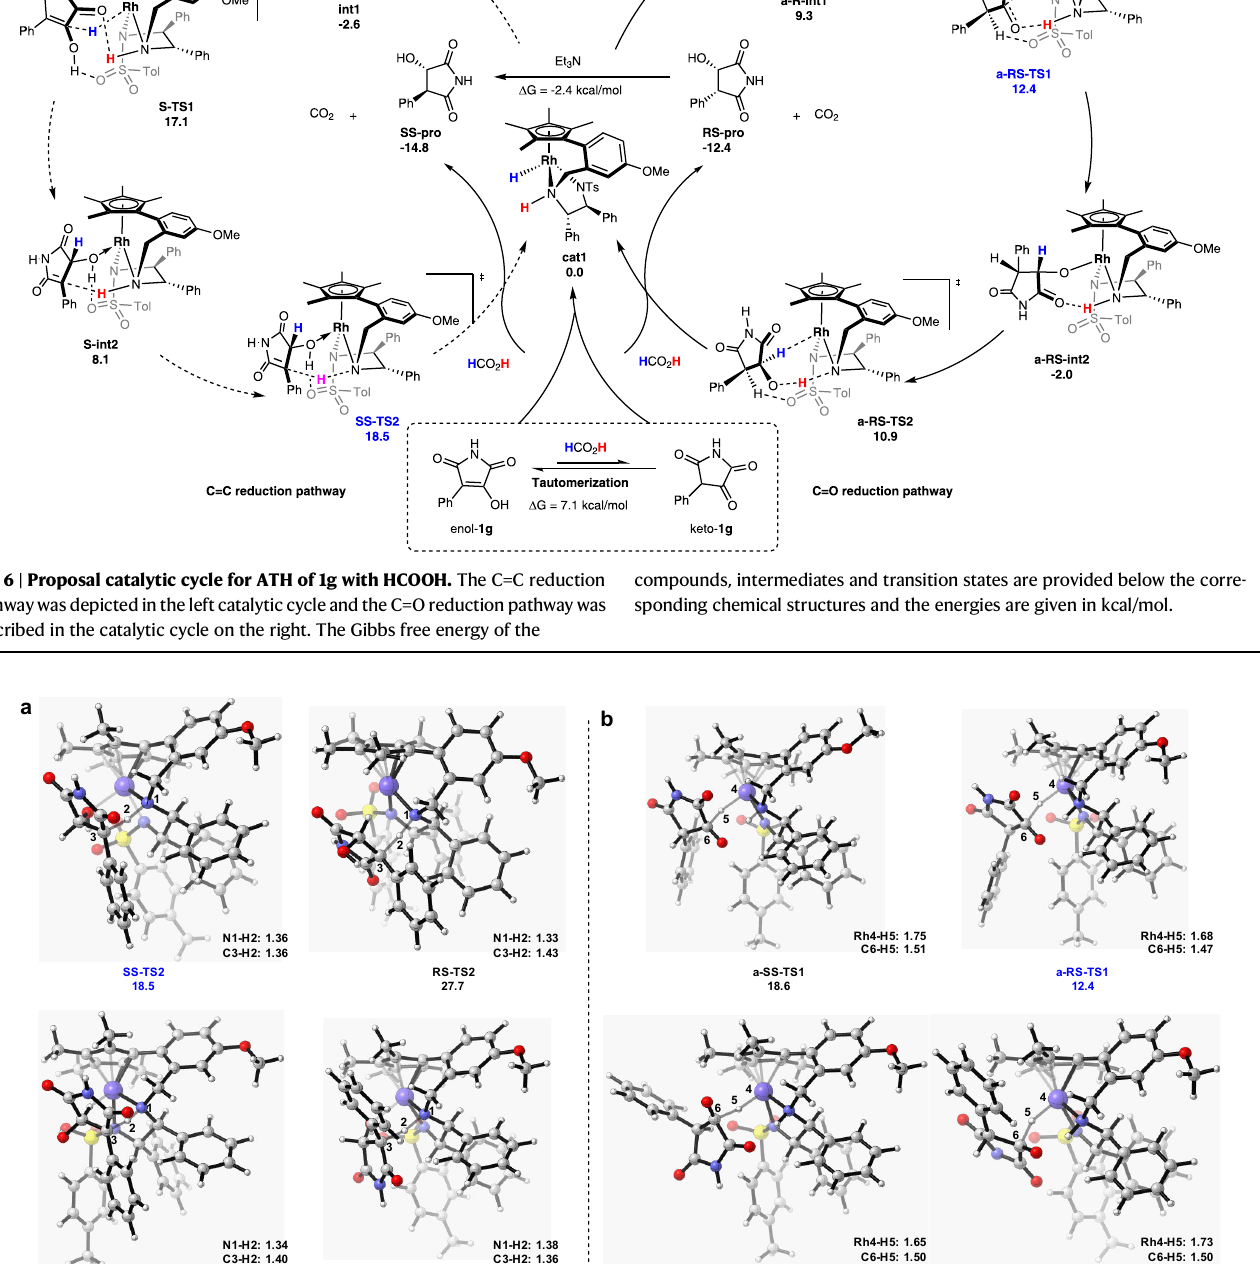
Fig. 7 | The free energies of the transition states of the enantio-determining steps. a Calculated transition states for the C=O bond reduction pathway. b Calculated transition states for the C=C bond reduction pathway. The energies are given in kcal/mol. The lengths are given in angstrom.